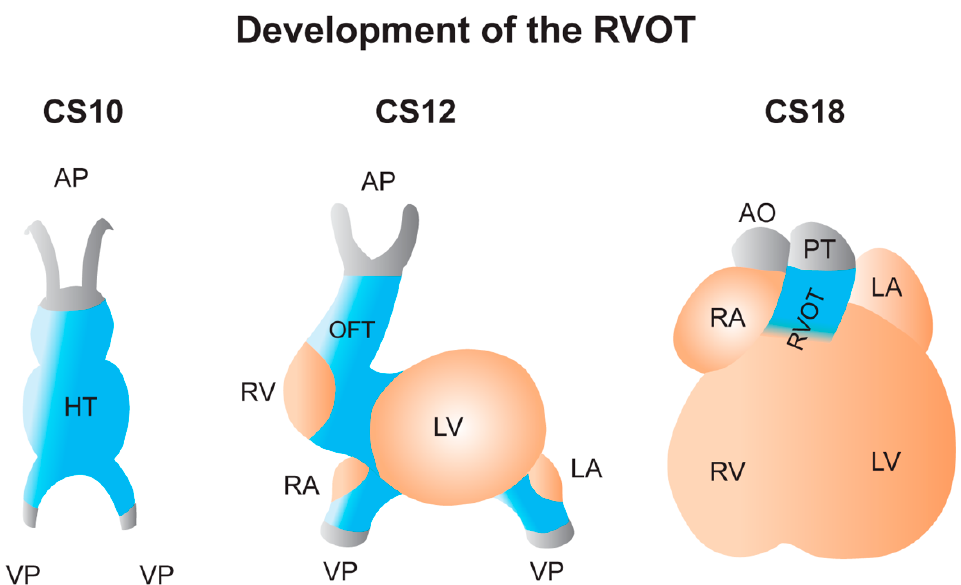
Figure 2. Development of the RVOT. Primary myocardium is indicated in blue and the embryonic working myocardium in orange. The embryonic outflow tract (OFT, composed of primary myocardium) gives rise to the (future) RVOT in the fetal and adult heart. During Carnegie stage (CS) 10, i.e., after 28 days of development, the arterial pole and venous poles of heart tube (HT) elongate by continuous proliferation and addition of cardiac progenitor cells. It is from CS10 that rightward looping of the linear heart tube initiates. During CS12 (i.e., day 30), as the heart tube loops, the cardiac chambers start to balloon out. At this stage, further elongation of the arterial pole has given rise to the tubular outflow tract (OFT) which connects the right ventricle (RV) to the aortic sac and aortic arches. During CS16 (i.e., day 39), the OFT has become relatively shorter with concomitant incorporation of its proximal part into the RV. Septation of the proximal OFT initiates at CS14, proceeds during CS16 by septation of the distal OFT, thereby giving rise to the pulmonary and aortic channels at CS18. At CS18 (i.e., day 44), the OFT is configured as for the postnatal heart. Both pulmonary and arterial components of the OFT are relative to each other in a spiral orientation. AP, arterial pole; VP, venous pole; LV, left ventricle; LA, left atrium; RA, right atrium; RVOT, right ventricular outflow tract; AO, aorta; PT, pulmonary trunk.